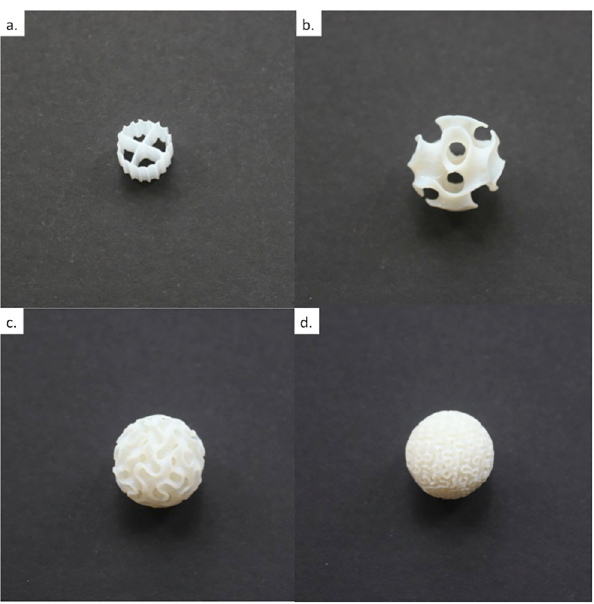
Fig 1. Images of commercial (K1) and fabricated (gyroid) biocarrier designs examined in this research. (a) Kaldnes K1; (b) small specific surface area gyroid; (c) medium specific surface area gyroid; (d) large specific surface area